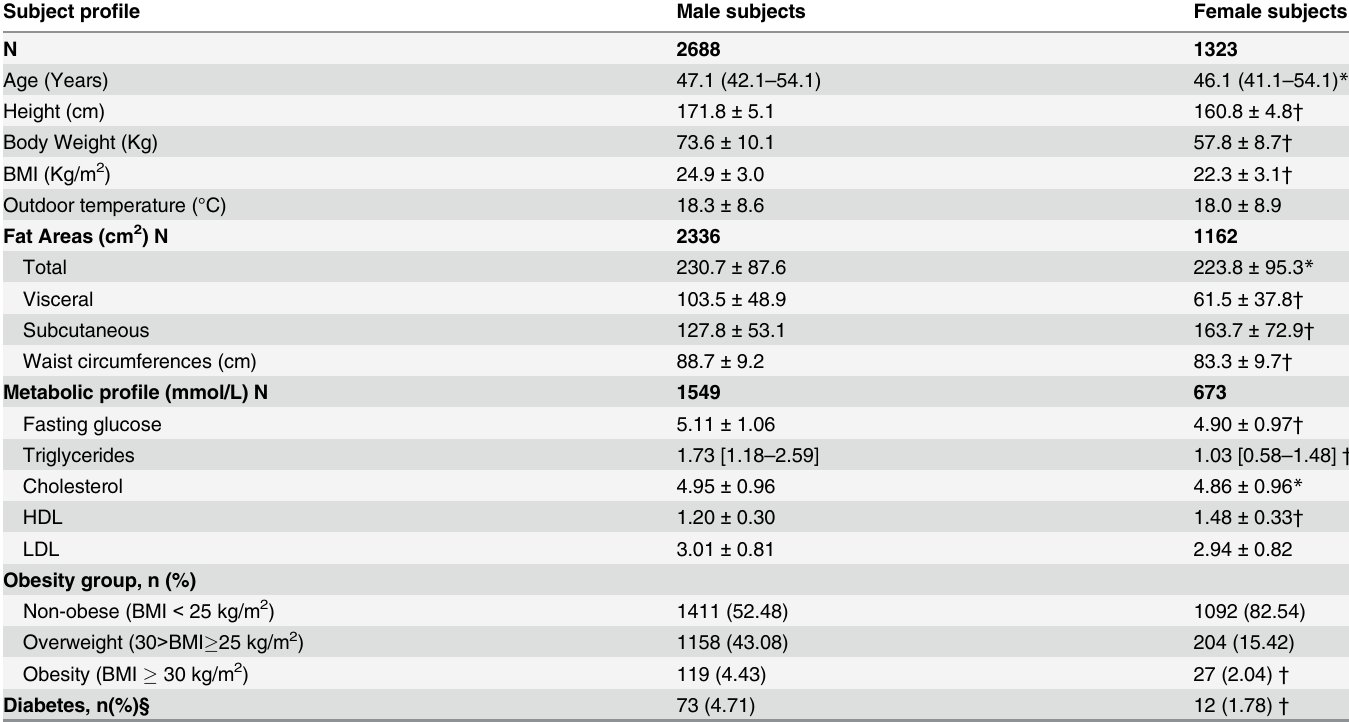
Table 1. Characteristic of the study